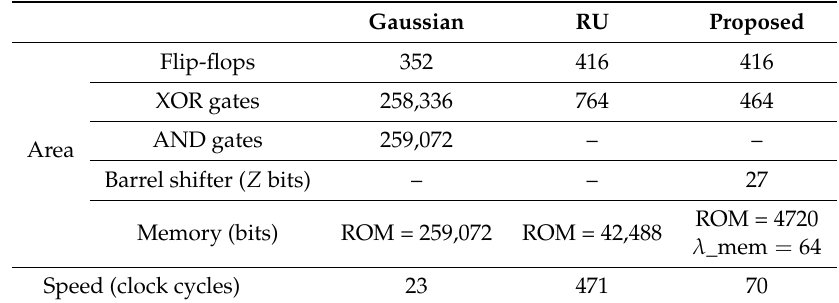
Table 6. Comparison between Gaussian method, RU method, and proposed method for submatrix size Z =